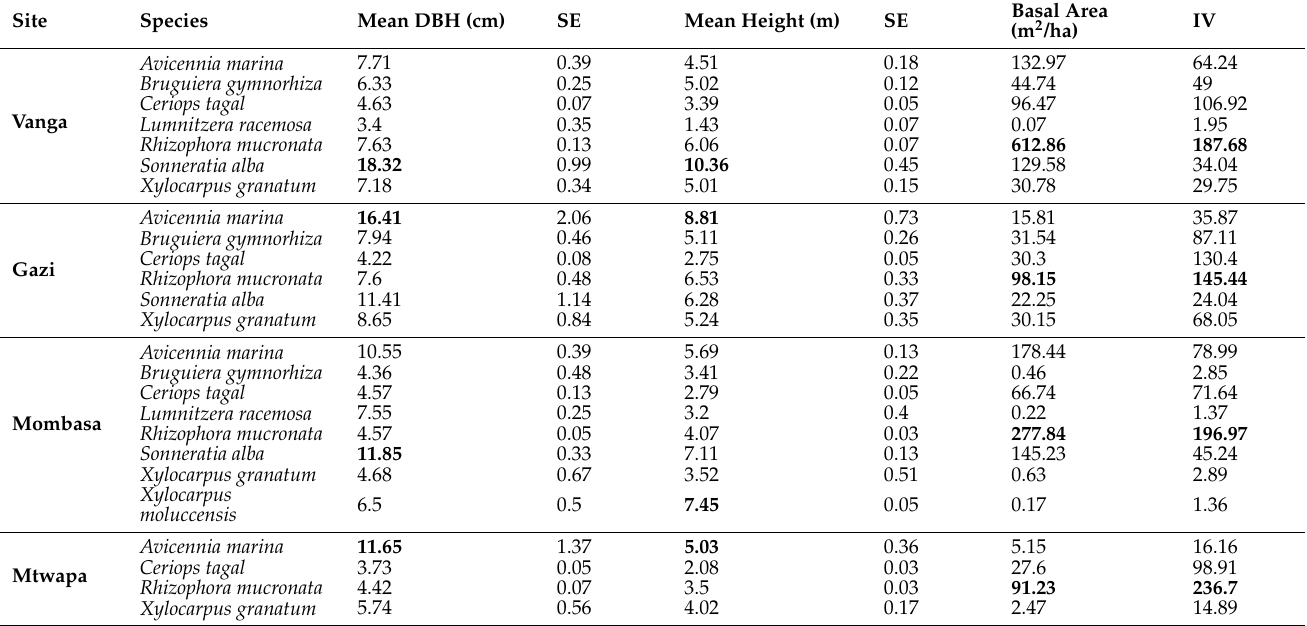
Table A1. Structural attributes of the various sampled species across the 14 sampled sites. SE is standard